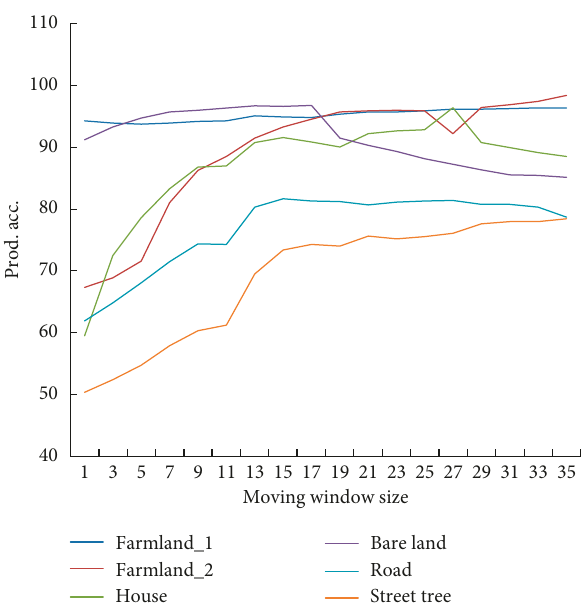
Figure 10: Producer accuracy curves of objects in different scales.